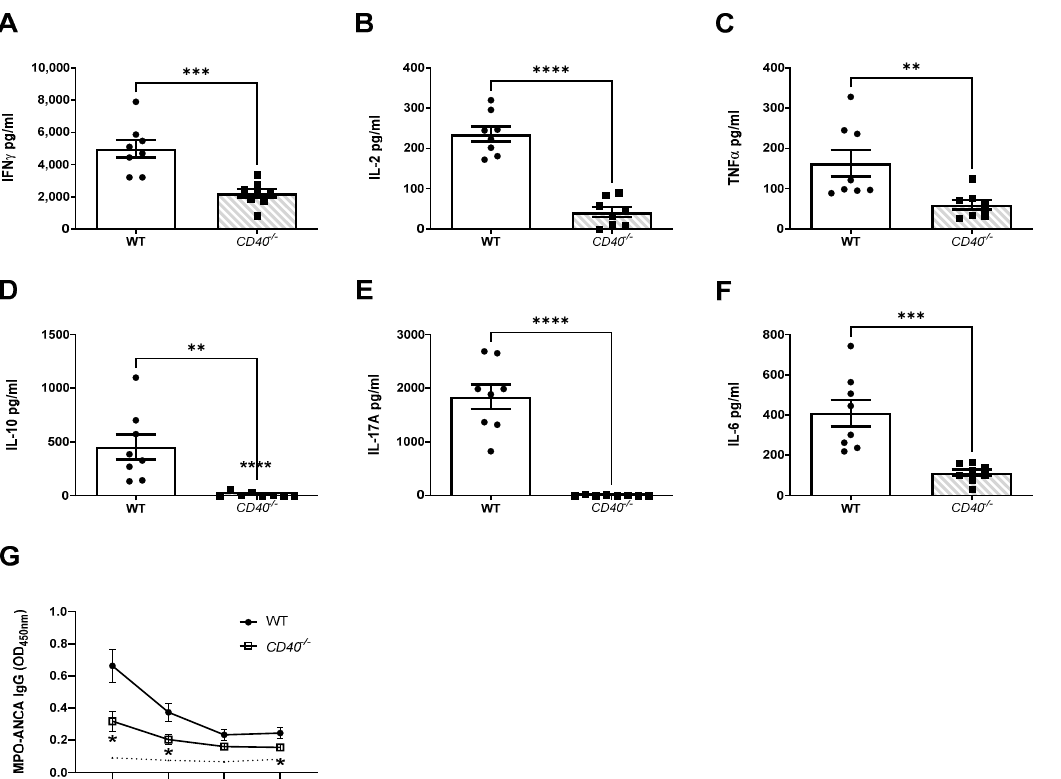
Figure 5. CD40 upregulation on TLR9 stimulated MPO pulsed dendritic cells is critical for the enhancement of MPO autoimmunity. Early Immune Responses Model (Day 10): ( A ): Reduced production of IFN- γ in mice receiving TLR9 stimulated MPO pulsed CD40 − / − DCs compared to WT DCs. ( B ): Reduced production of interleukin 2 (IL-2) in mice receiving TLR9 stimulated MPO pulsed CD40 − / − DCs. ( C ): Reduced production of TNF α in mice receiving TLR9 stimulated MPO pulsed CD40 − / − DCs. ( D ): Reduced production of interleukin 10 (IL-10) in mice receiving TLR9 stimulated MPO pulsed CD40 − / − DCs. ( E ): Reduced production of IL-17A in mice receiving TLR9 stimulated MPO pulsed CD40 − / − DCs. ( F ): Reduced production of interleukin 6 (IL-6) in mice receiving TLR9 stimulated MPO pulsed CD40 − / − DCs. ( G ): Decreased serum MPO-ANCA IgG in mice receiving TLR9 stimulated MPO pulsed CD40 − / − DCs compared to WT DCs. Dotted line represents the OD 450 of sera from control, OVA immunized mice receiving anti-GBM globulin. Bars show the mean +/ − SEM. ** = p < 0.01, *** = p < 0.001, **** = p < 0.0001. DC = Dendritic cell. Mouse numbers for experiment: WT: n = 8, CD40 − / − : n =